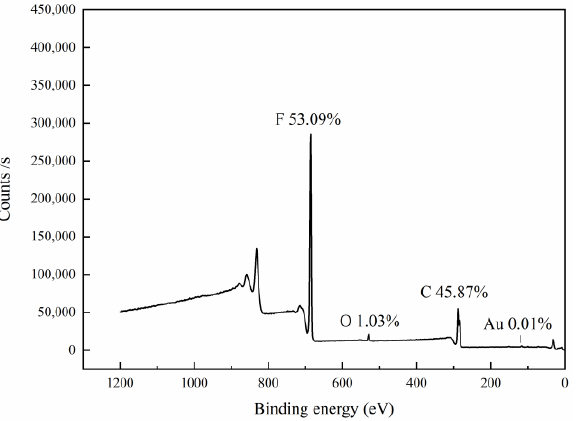
Figure 5. XPS image of fiber membrane of the PVDF fiber fabricated together with AuNPs.